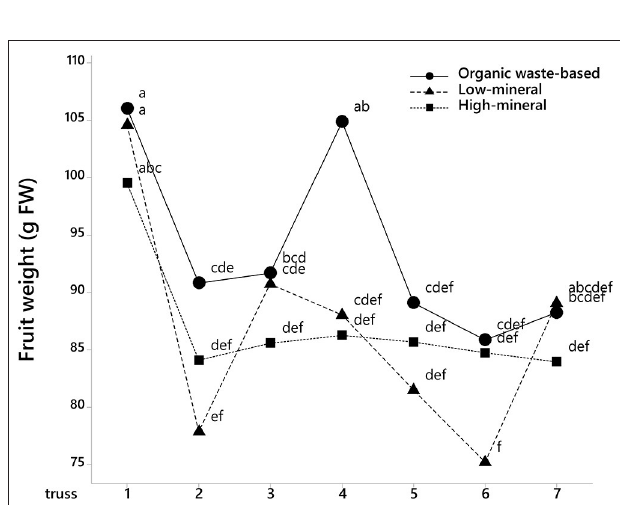
FIGURE 2 | The average weight of tomato fruits at different positions on truss, where 1 is the first to bear fruits on the truss. Mean values are shown. Different letters indicate statistically significant differences at p = 0.05, n = 47–70.